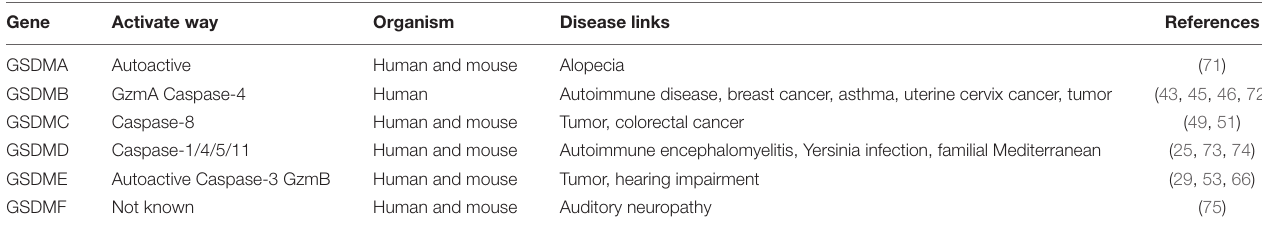
TABLE 1 | Characteristics of GSDM family